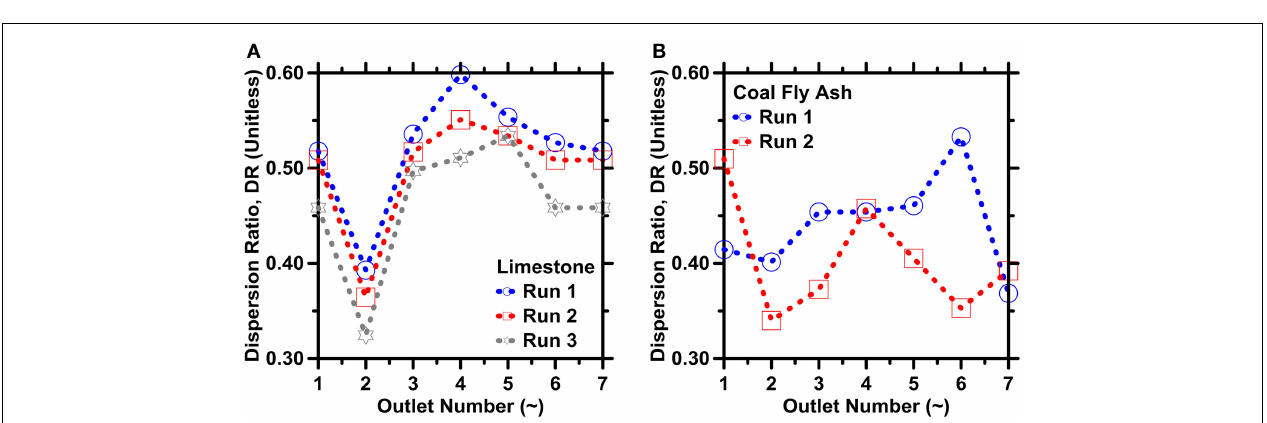
FIGURE 8 | The dispersion ratio for: (A) limestone and (B) FA particles as retrieved from the different device outlets . The highest uncertainty in DR based on ICA on replicate images is on the order of 10% for limestone and 17% for coal fly ash, respectively.